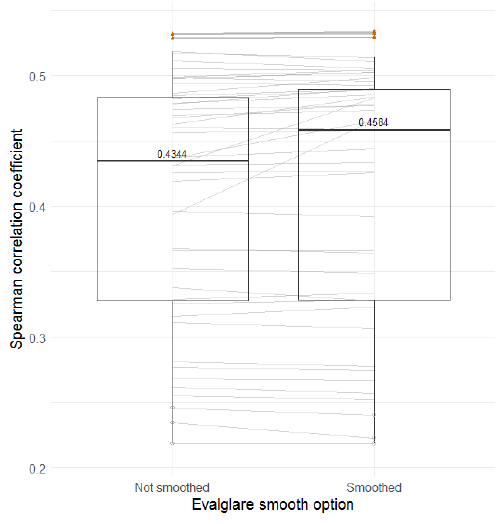
Figure 33. Boxplots of Spearman rho for the non-smooth/smooth parameter (laboratory study). Buildings 2018 , 8 , x FOR PEER REVIEW